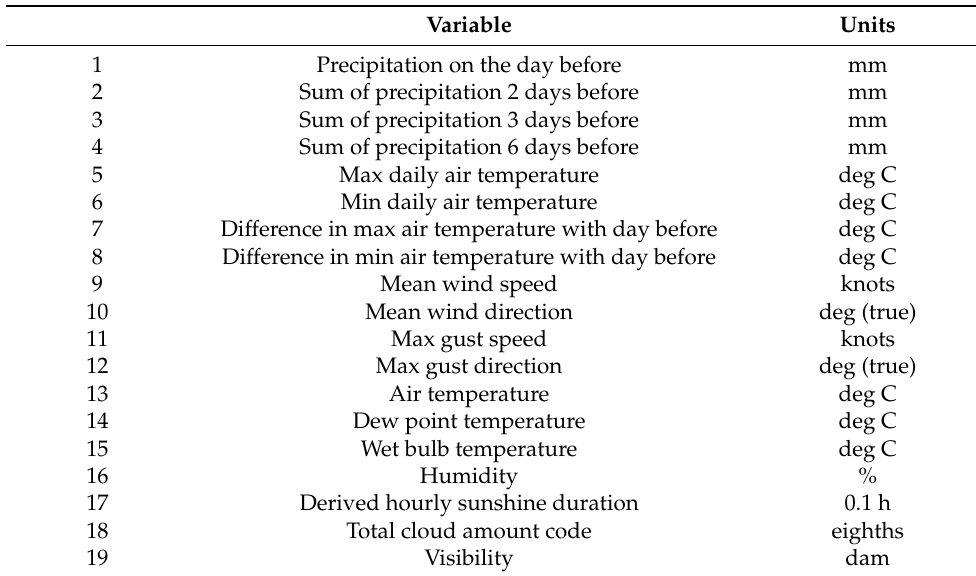
Table 3. Fault predictive weather variables.